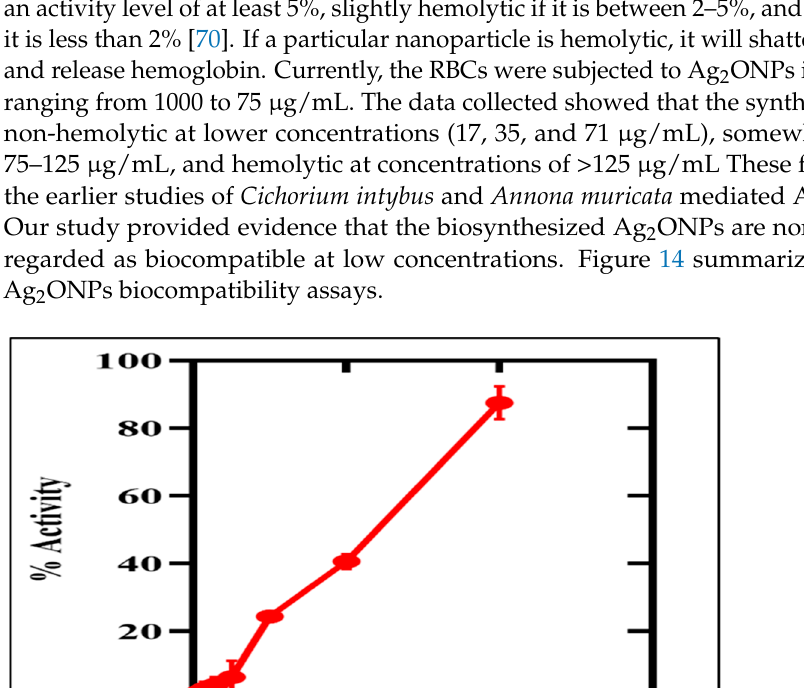
Figure 14. The antihemolytic potential of P. alsinaefolia -mediated Ag 2 ONPs.